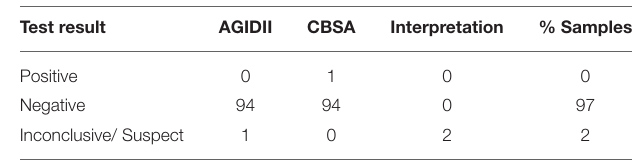
TABLE 1 | Test results and interpretation of rough strain Brucella canis tests for 95 prospective samples.